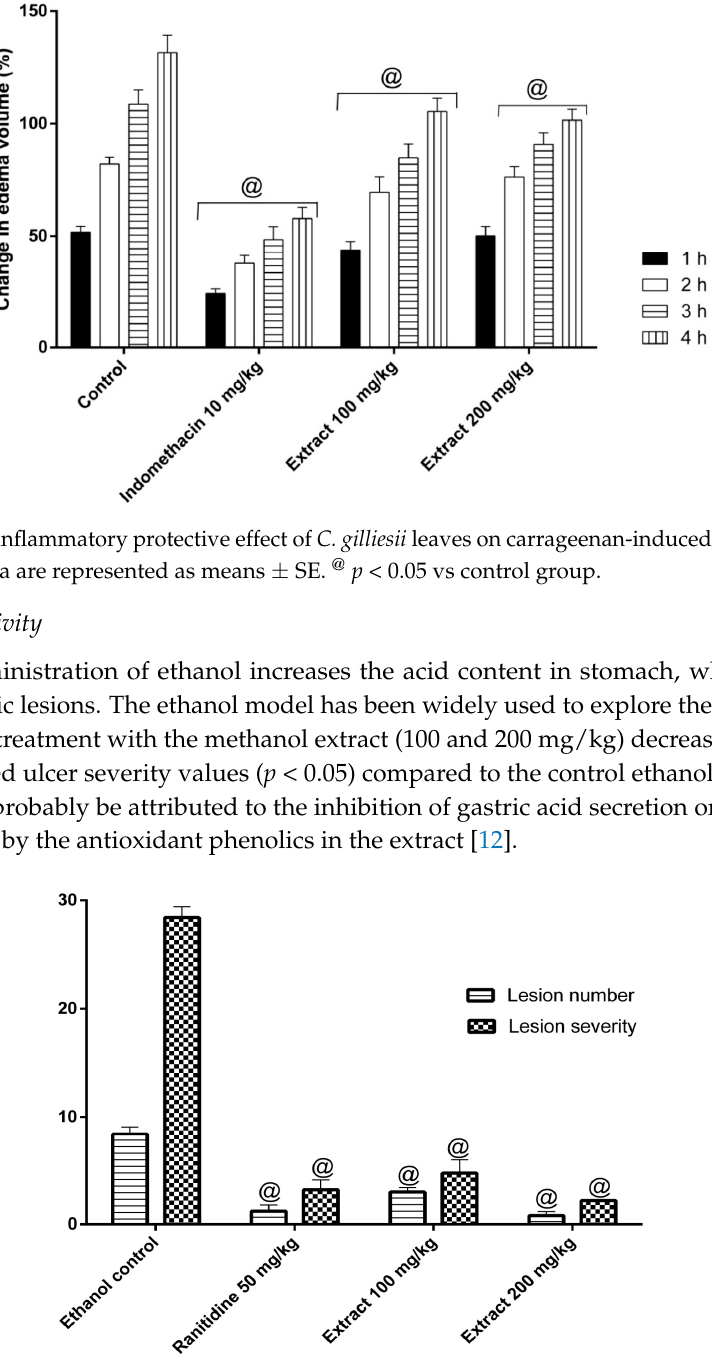
Figure 5. Anti-ulcer effects of the methanol extract of C. gilliesii leaves ( n = 6). Statistical analysis was performed by Kruskal-Wallis non-parametric one way ANOVA followed by Mann Whitney multiple comparisons test. @ p < 0.05 vs control ethanol group.